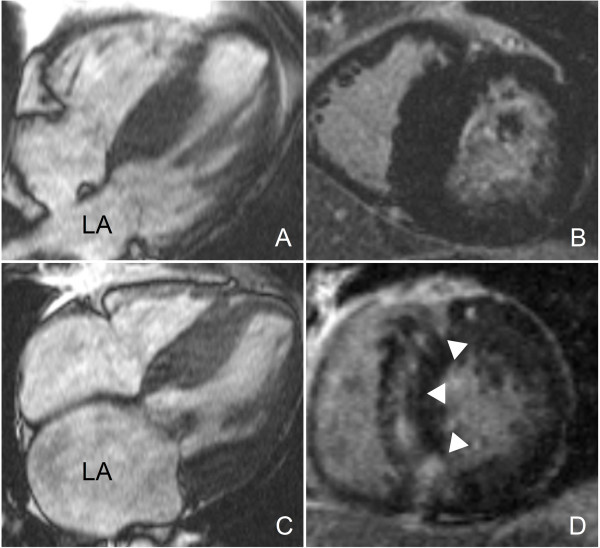
HCM patients with comparable left ventricular mass and different left atrial size. A, C. End diastolic 4 chamber cine images. Note that the left atrium of the first patient (A) is smaller compared to the left atrium of the second patient (C), despite comparable LV mass. The end diastolic short axis LGE images (B, D) reveal that the first patient (B) has no LGE, while the second patient (D) has extensive LGE of the septum, as indicated by the white arrowheads.